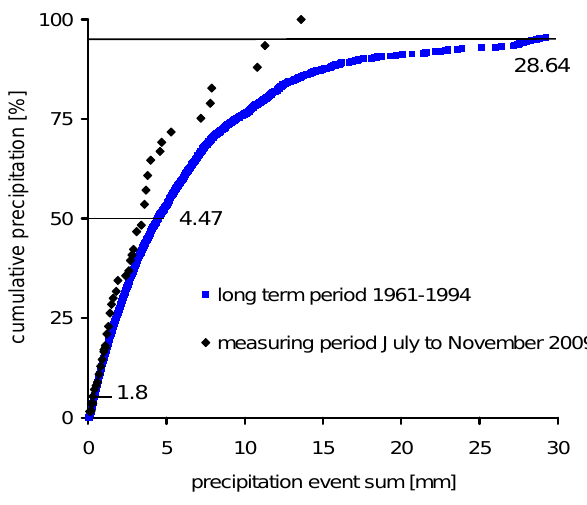
Fig. 1. Contribution of individual precipitation event sums (sep- arated by a 10min dry period) to the cumulative sum of precip- itation at the station Berlin-Marienfelde, 1961–1990 (solid line, N=11363) and of the rain events during the observation period of this study, 8 July to 30 November 2009 (dashed line, N=154). The 5%, 50% and 95% quantiles are marked for the period